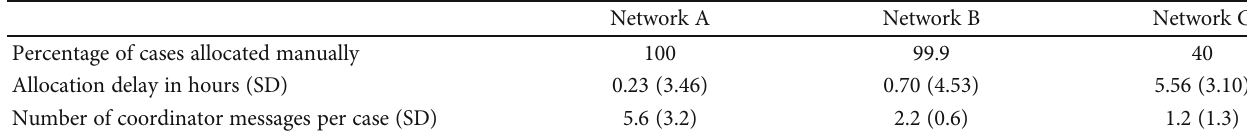
Table 7: Case management in the fi rst six months of